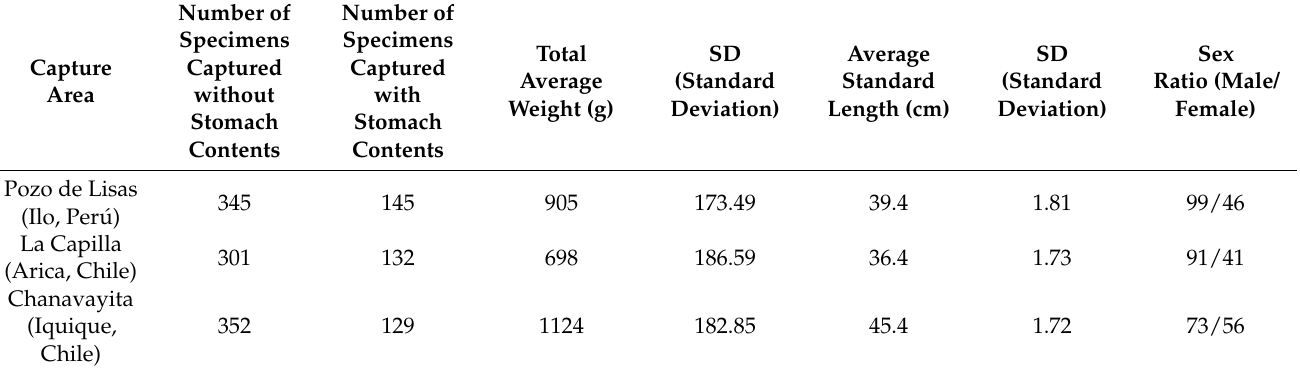
Table 1. Average weight, standard length, and sex ratio of Sarda chiliensis chiliensis in all three sampling